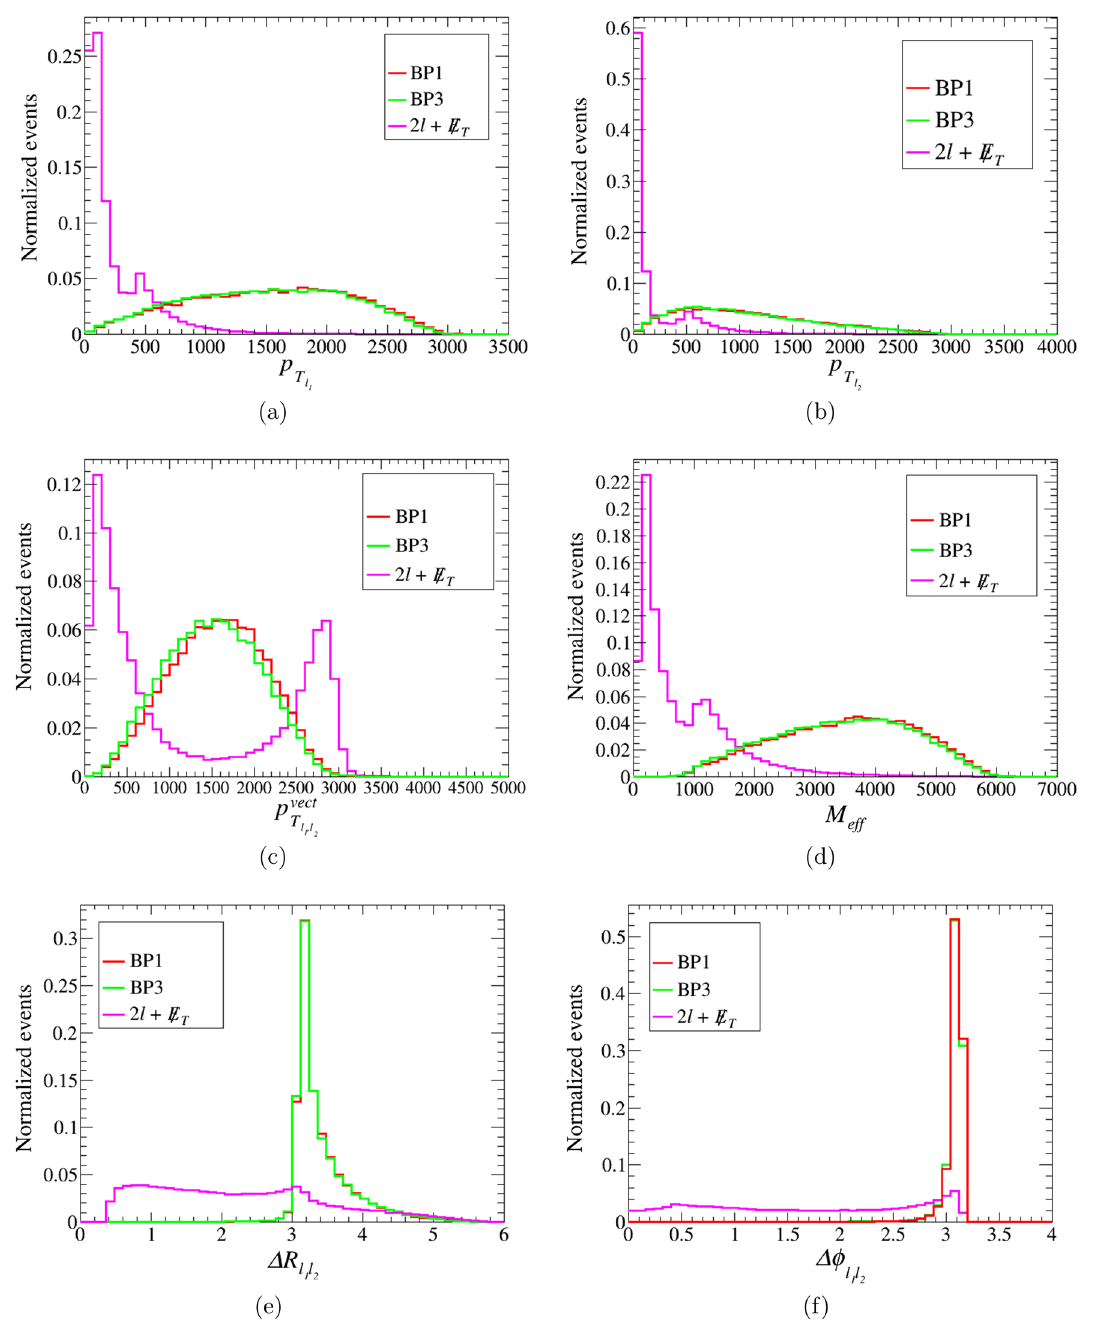
Fig. 5 Normalized distributions of the kinematic variables a p T , b p T , c p v ect , d M ef f , e (cid:12) R l T l 1 , l 2 l 1 l 2 for 2 l + E T / channel at 6 TeV muon collider transverse momenta of two leptons in the final state for √ s = 6 TeV (14 TeV). It is signal and background for defined as: (cid:16) ≡ ( p + p ) 2 + ( p + p ) 2 + ( p + p ) 2 p v ect Tx l 1 Tx l 2 Ty l Ty l Tz l 1 Tz l 2 T l 1 , l 2 1 2 , p , y , z -components Here, p Tx Ty li and p Tz li are the x li of the transverse momentum vector for i = 1 , 2